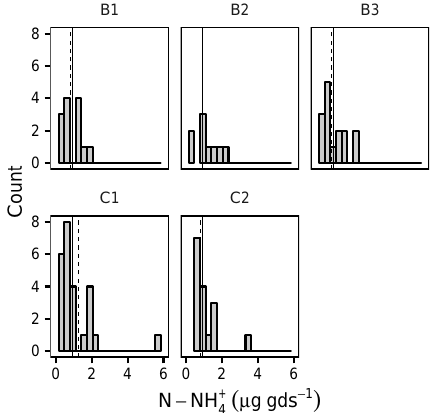
Figure 3. Histogram of soil NH + concentrations (reported per gram 4 of dry soil, gds) prior to prescribed burns. Solid vertical lines indi- cate the median concentration across all sites; dashed vertical lines indicate the site-specific median concentration.